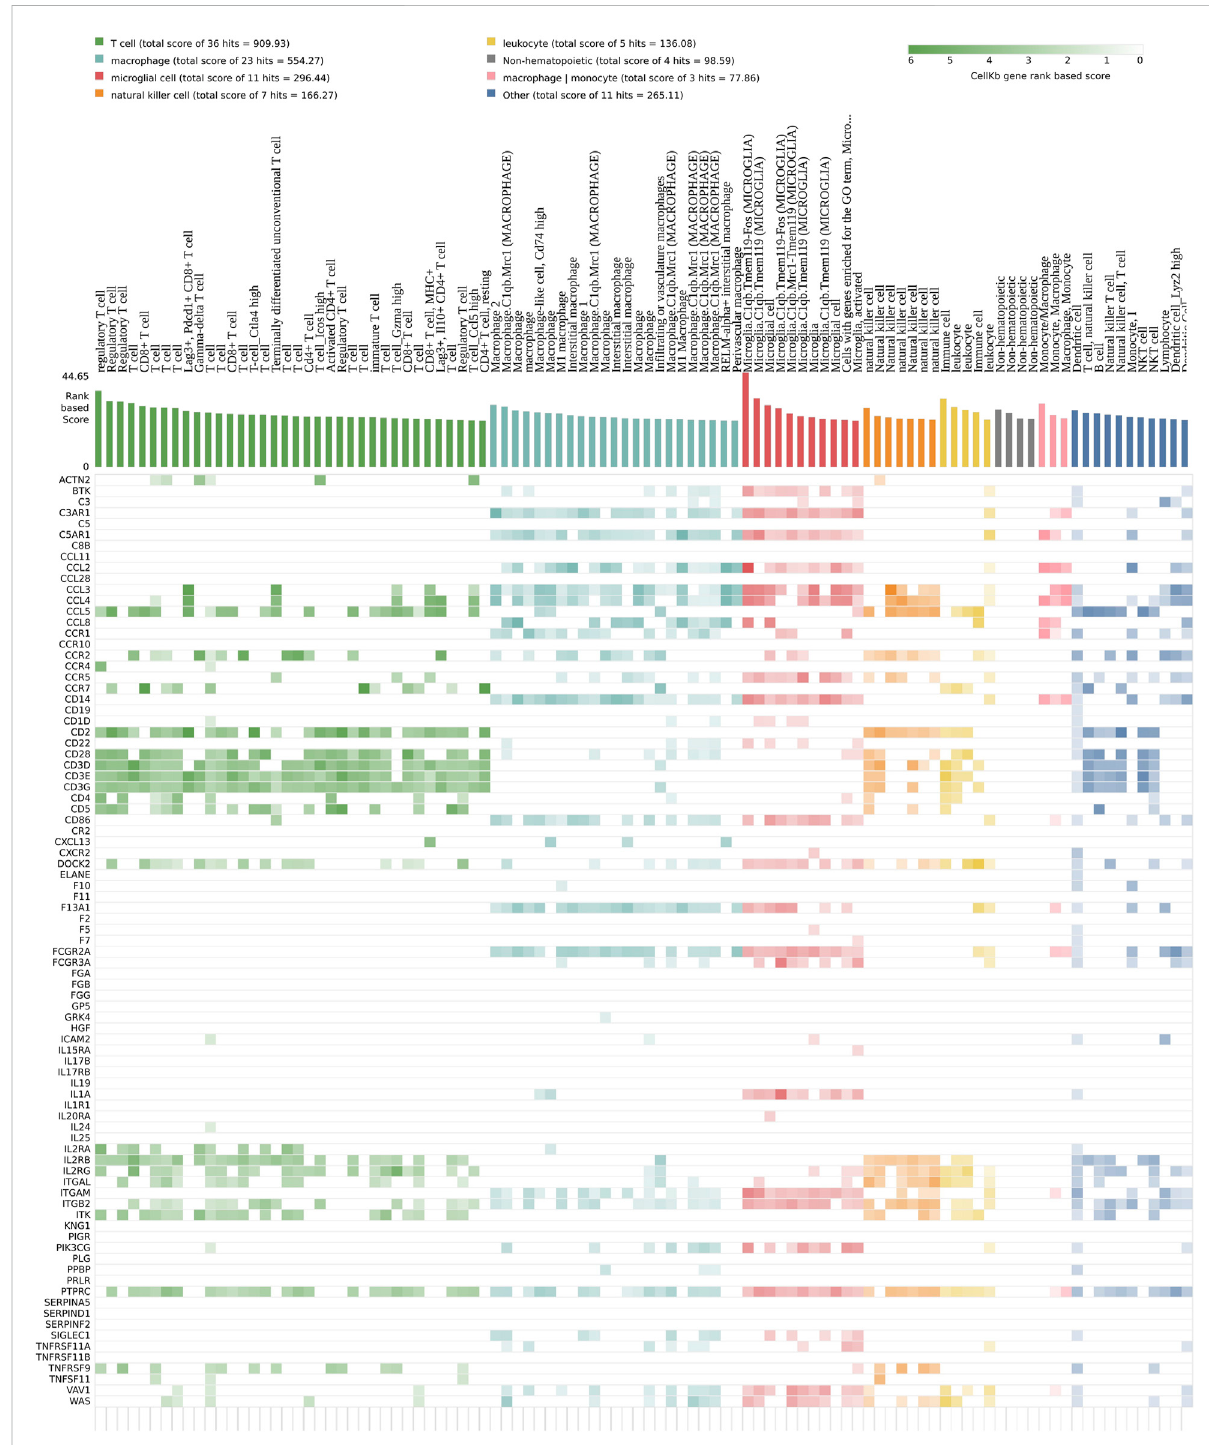
FIGURE 6 The transcriptional signature of the subnetwork corresponds to immune system functions. DE genes are compared to expression changes speci fi c of individual immune cell types. Color code is according to the various cell lineages, where strong colors correspond to higher